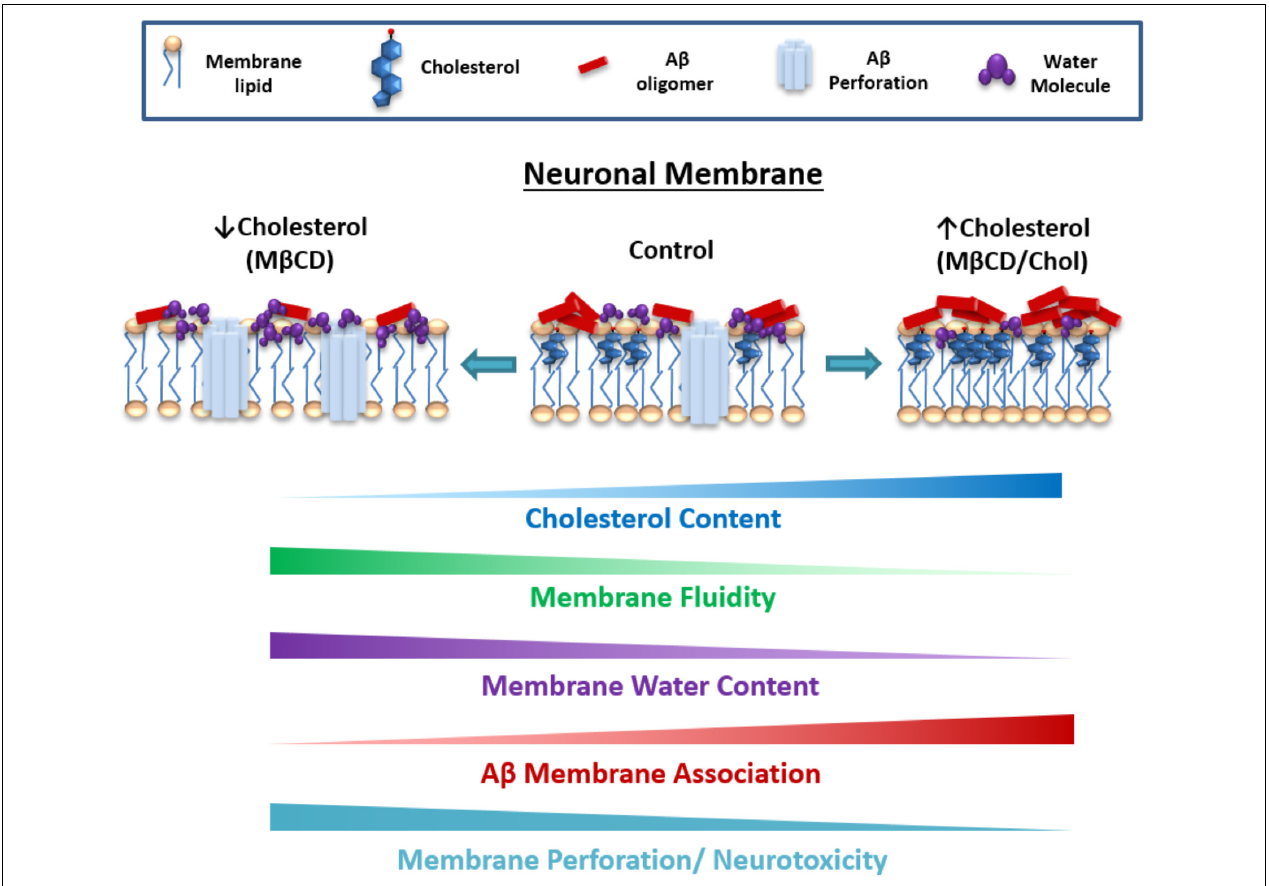
FIGURE 6 | Proposed model for the role of cholesterol content and membrane fluidity in the early neurotoxic actions of A β . Cholesterol augmentation reduces fluidity and water content of the membrane and favors A β association (clusters) on the surface of the bilayer. In parallel, cholesterol appears to attenuate A β perforation, possibly making it difficult for the peptide to insert in the membrane because of the presence of more rigid domains. On the contrary, increase in membrane fluidity with reduced cholesterol appears to reduce A β association, making the membrane more susceptible to be disrupted by smaller A β conformations